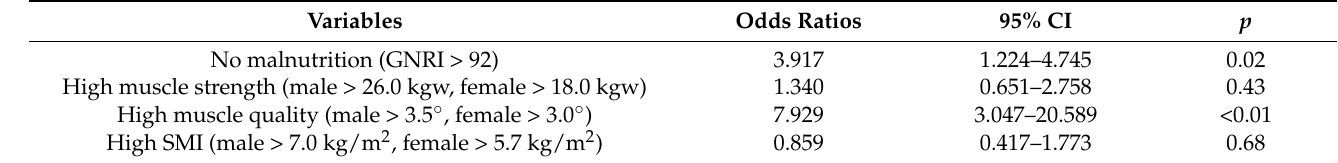
Table 5. Associations between functional recovery and clinical